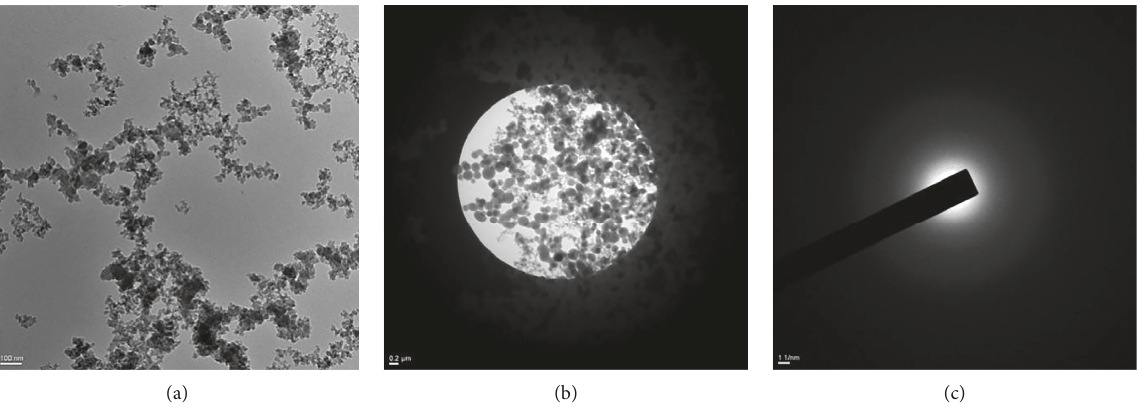
Figure 5: TEM image of the Si x O y @F nanocomposite and its